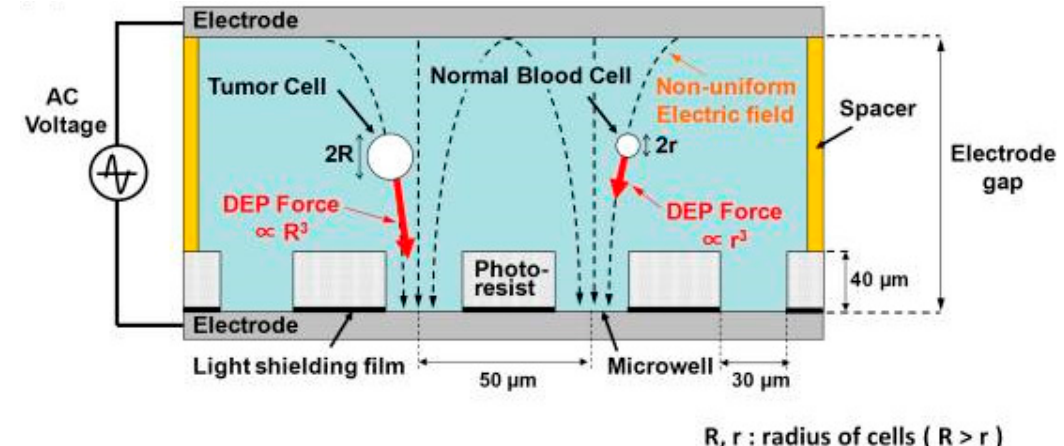
Figure 10. Schematic image of capturing cells using DEP force. (Reprinted from [66]).